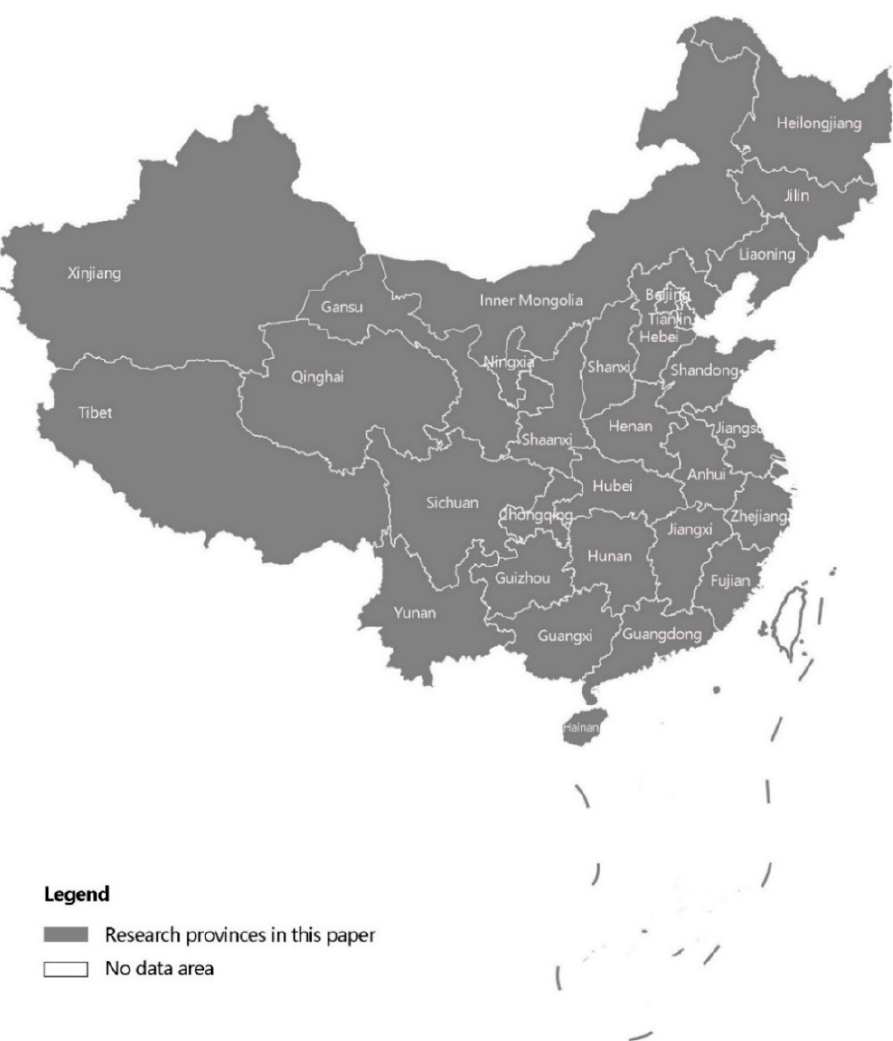
Figure 1. Study area.